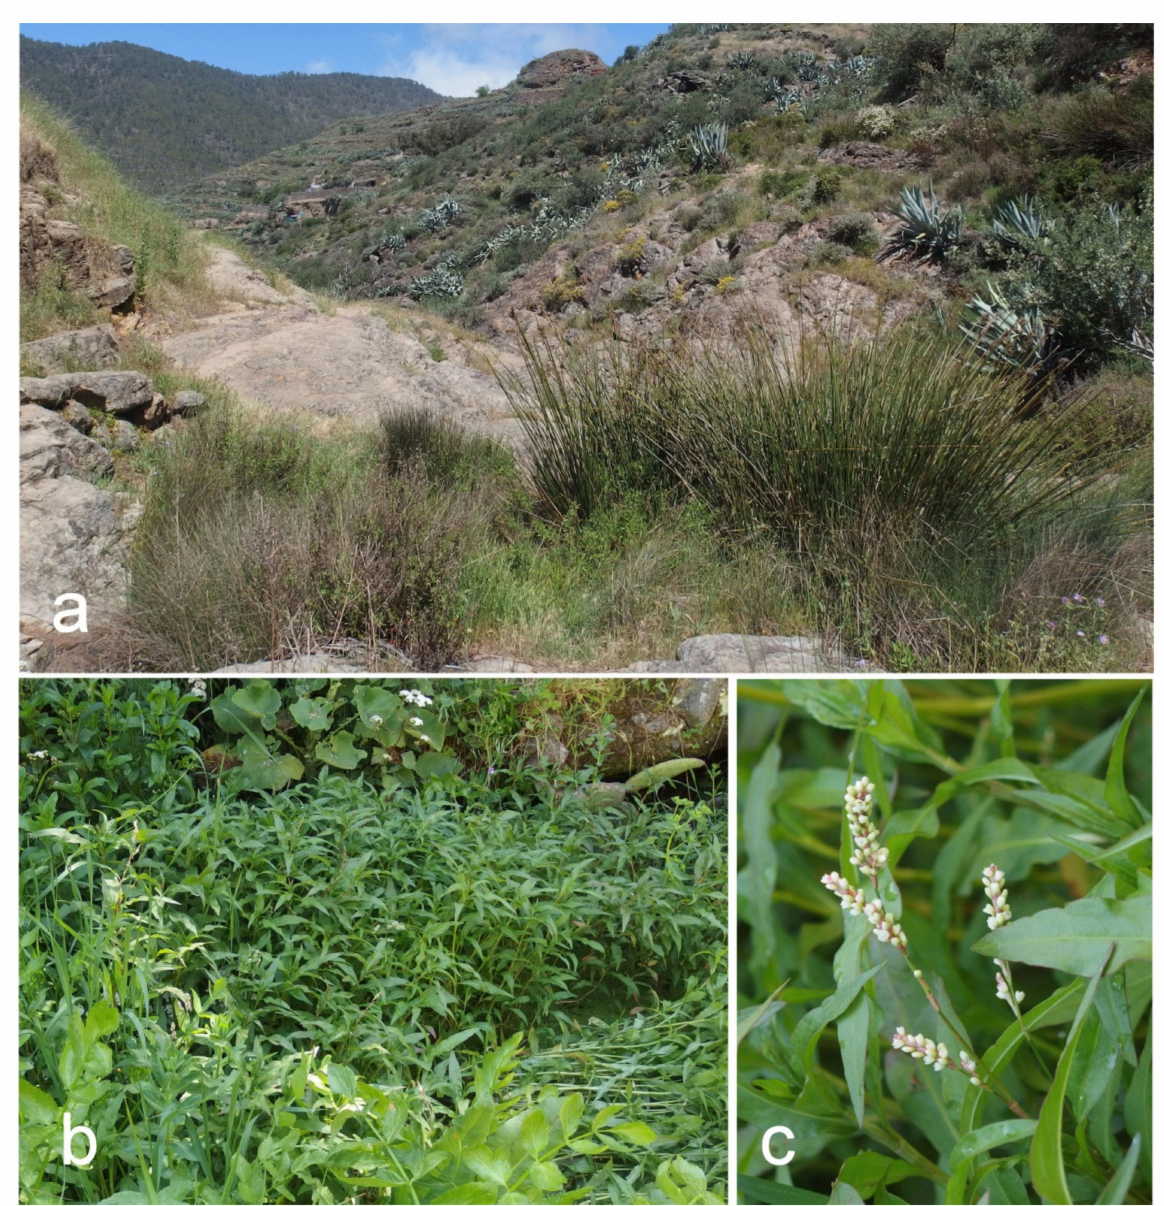
Figure 6. Persicaria hydropiperoides in Gran Canaria, Barranco de Lugarejos, April 2017: ( a ) general view of the rather remote and natural area in which the species is naturalized, ( b ) the species co-dominates the vegetation in riverlets and drains, ( c ) detail of inflorescence (flowers can range in color from pink to white) (Photographs: F.